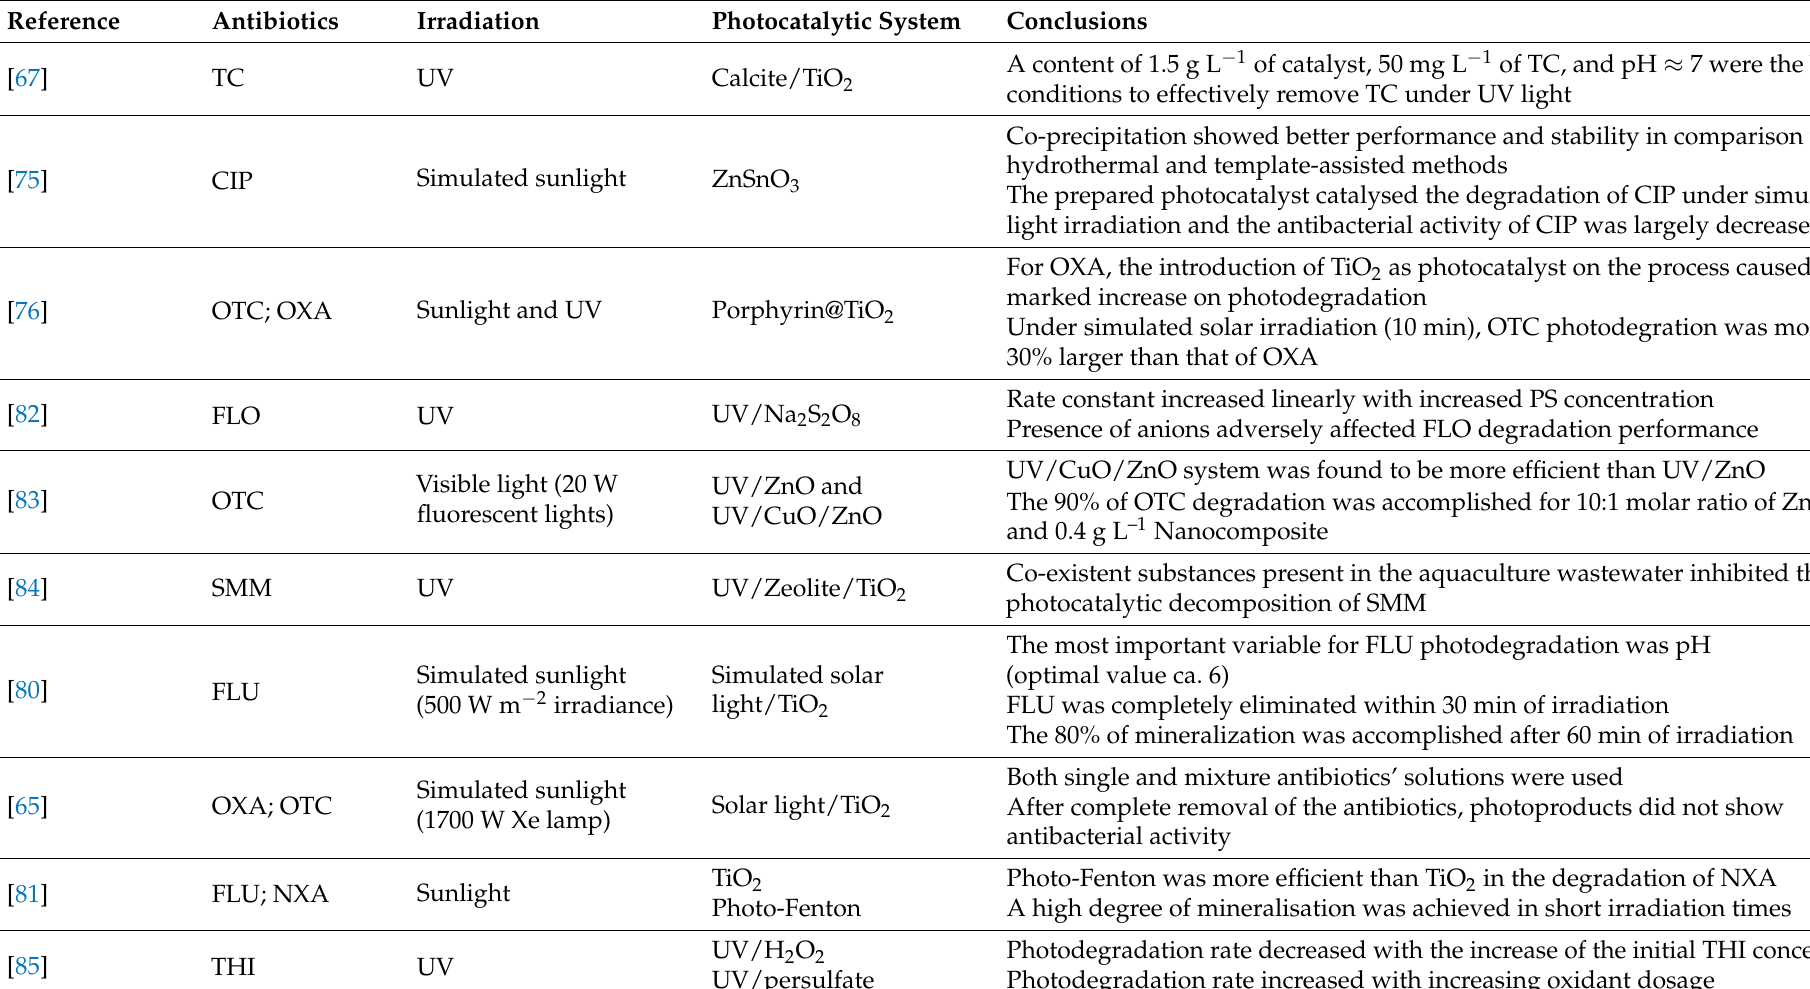
Table 2. Photocatalysis of antibiotics used in